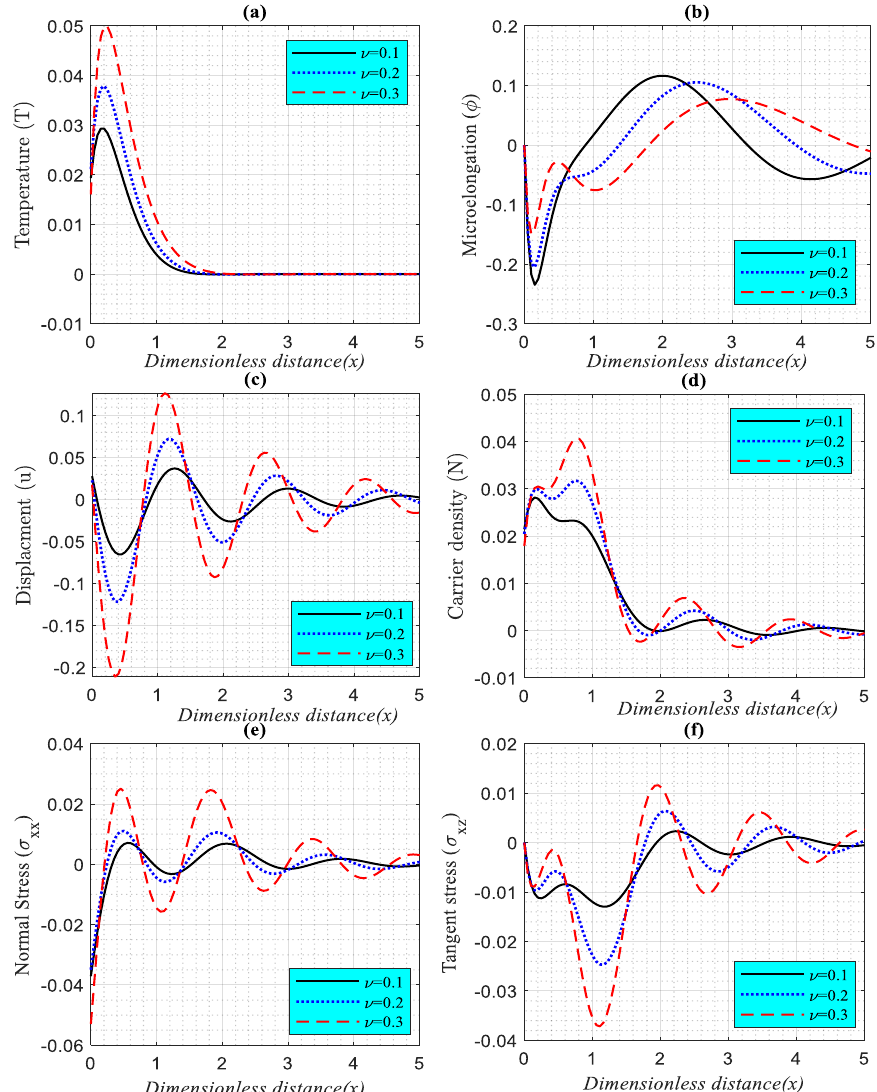
Figure 3. a-f. The variation of the main physical fields versus the horizontal distance according to the differences in the laser pulse rise-time parameters under the effect of rotation parameter.